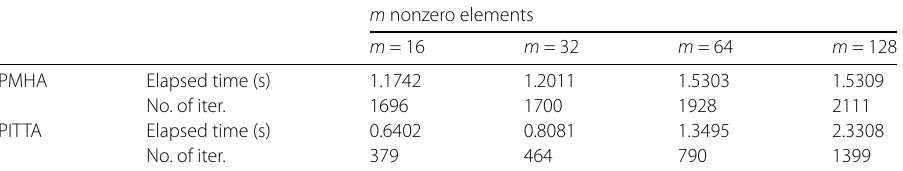
Table 9 Numerical comparison of two